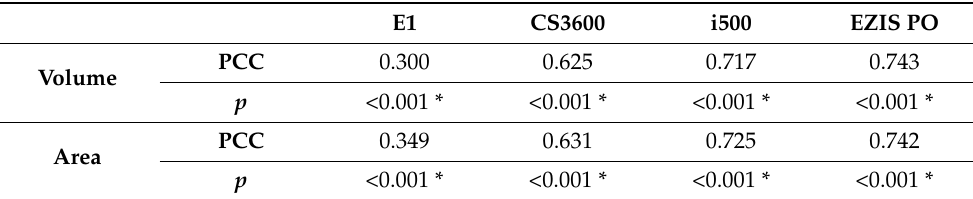
Table 3. Correlation coefficient values for volume, area, and